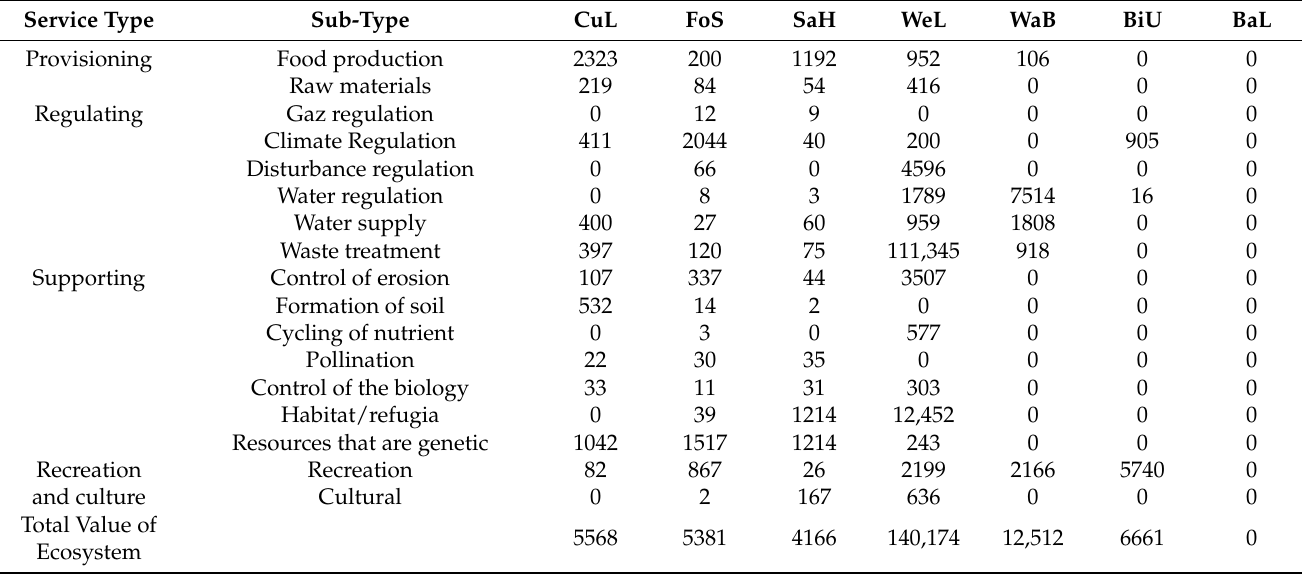
Table 2. ESV coefficients (US$ha − 1 1 yr − 1 ) of the corresponding biomes for Madagascar Island LULC types